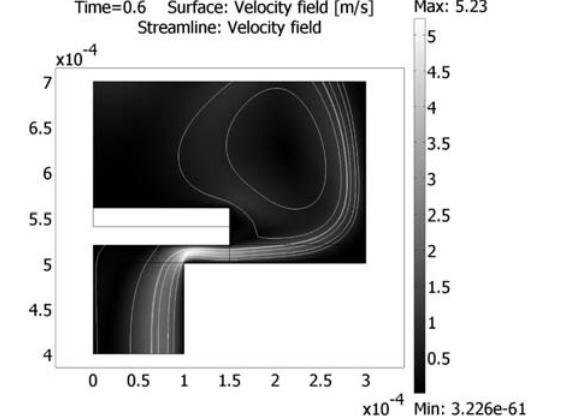
Fig. 5: The velocity field of the flow under an inlet pres- sure of 0.1 bar for a valve with a stiffness of 10 N/m and a pre-stress force of 10 × 10 − 5